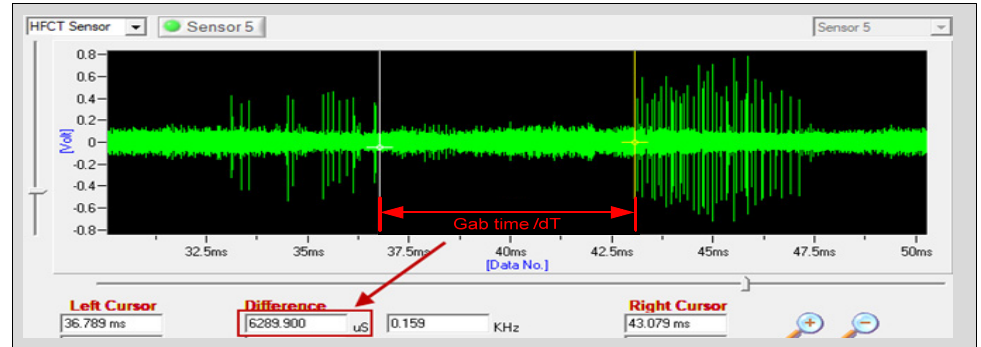
Figure 11. The PD signal waveform from HFCT sensor when all AE sensor installation on housing of high side transformer.